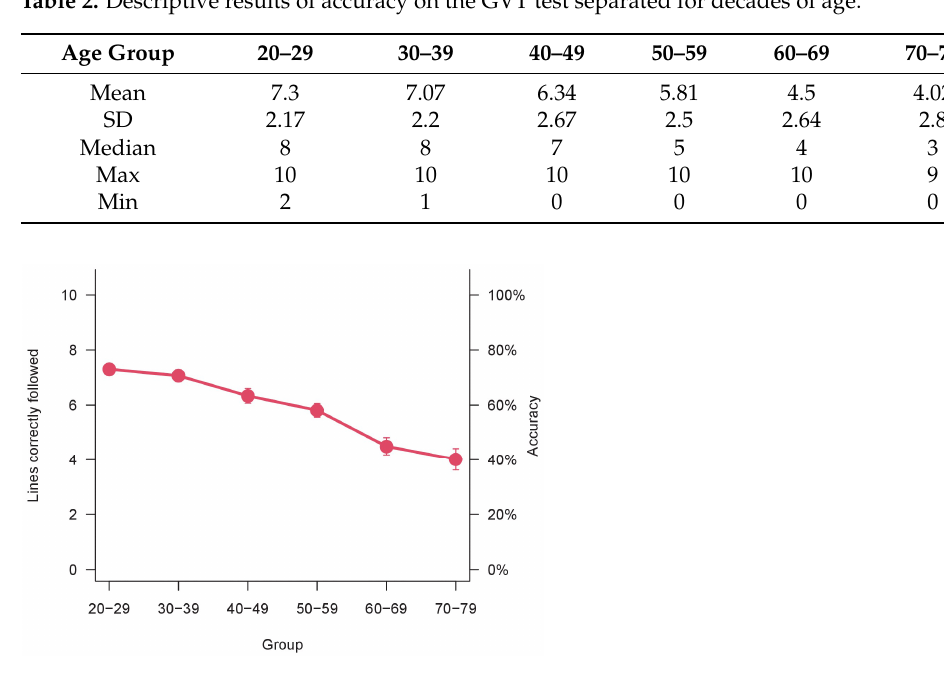
Figure 2. Accuracy over age groups. Bars represent ±1 SEM. Table 2. Descriptive results of accuracy on the GVT test separated for decades of age.